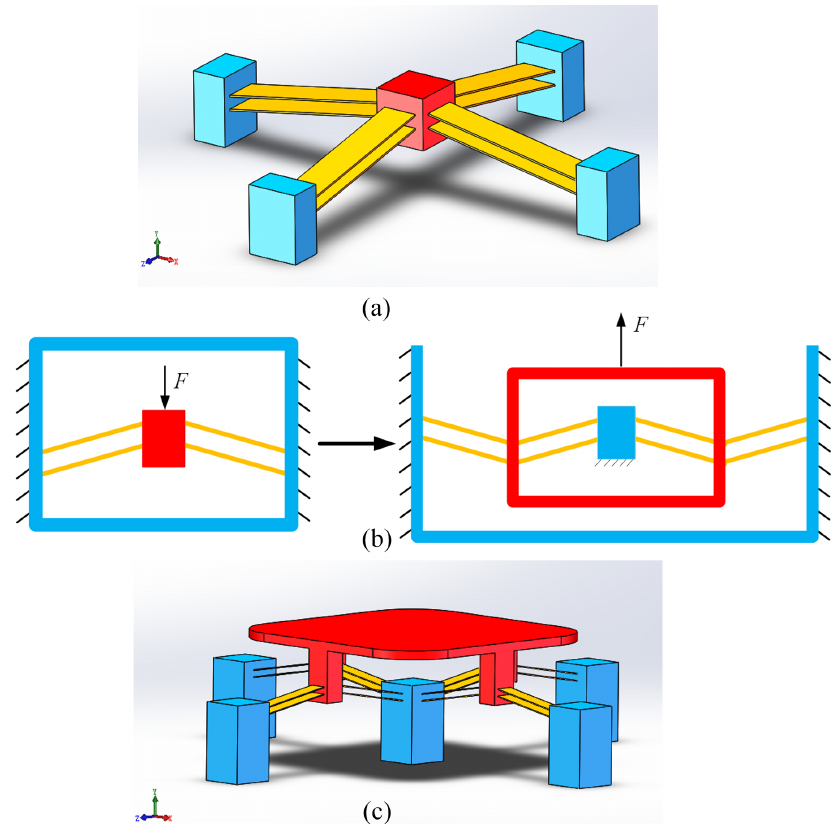
Figure 8. (a) Three-dimensional model of the Type A bistable mechanism. (b) The optimizing design process from the type A bistable mechanism to the type B bistable mechanism. (c) Three-dimensional model of the newly designed Type B bistable mechanism. The red, yellow and blue parts represent the moving platform, the fixed-guided beams and the fixed base, respectively.